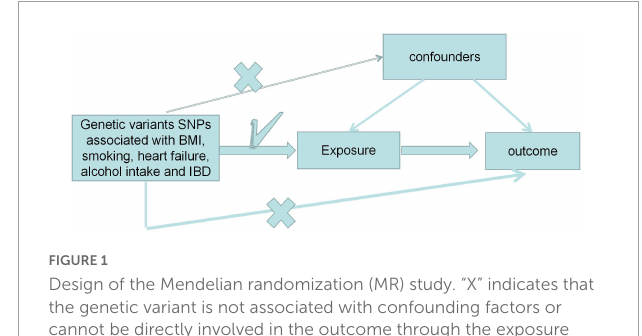
FIGURE1 Design of the Mendelian randomization (MR) study. “X” indicates that the genetic variant is not associated with confounding factors or cannot be directly involved in the outcome through the exposure √ pathway. “ ” means that the genetic variant is highly correlated with exposure. SNP, single nucleotide